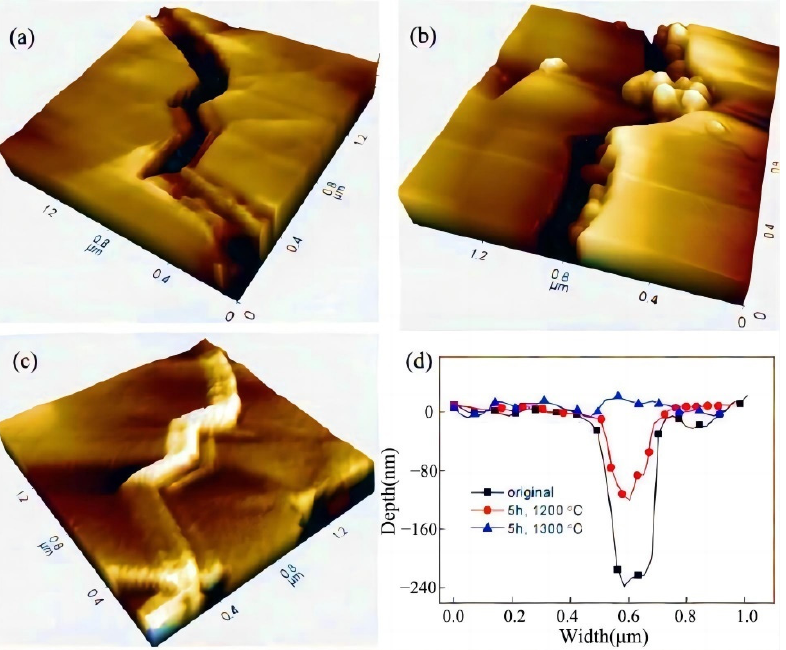
Figure 6. The Atom Force Microscope image of the NiAl particle with a size of 1 μ m and15 wt.%- reinforced Al 2 O 3 composite content ( a ) before the heat treatment, ( b ) at isothermal treatment at 1200 °C for 5 h and ( c ) at isothermal treatment at 1300 °C for 5 h. ( d ) The geometrical image of the crack fetched from the AFM before the heat treatment and after the heat treatment [51].